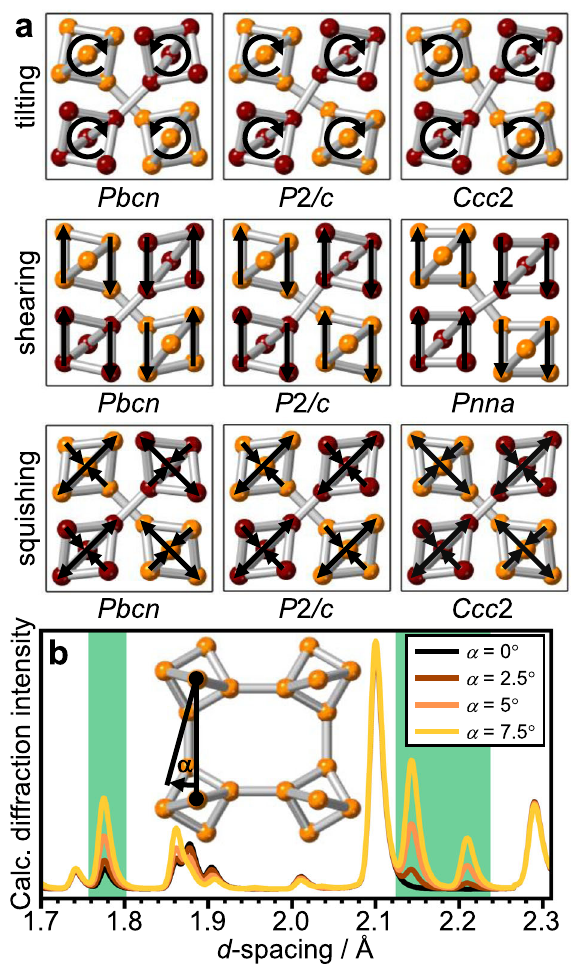
Fig. 3 Distortions of the ice VI structure and their effects on diffraction. a Schematic illustration of the possible distortions of ice VI by tilting, sheering, and squishing the hexameric units as illustrated by the arrows. The oxygen atoms of the two individual networks are shown in burgundy and orange, respectively. b Calculated diffraction patterns illustrating the emergence of ice XIX diffraction characteristics as a function of the tilt angle α for a Pbcn distortion. The green-shaded areas correspond to the ones shown in Fig. 2a. As shown in the inset, the axis of rotation is perpendicular to the paper plane and the angle is calculated from the projections into the plane of both the vector between the apex oxygens of neighbouring clusters and the apex to waist oxygen vector within a given